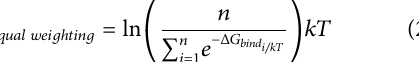
Frontiers in Molecular Biosciences |